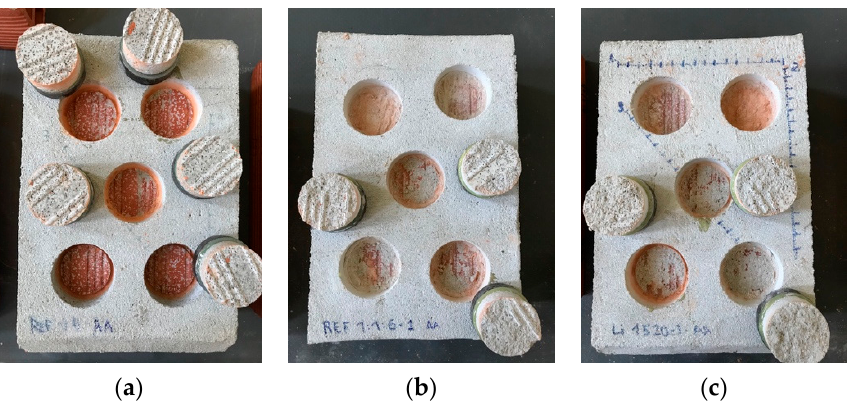
Figure 18. Adherence strength test after artificial accelerated ageing: ( a ) REF 1:4 (type A), ( b ) REF